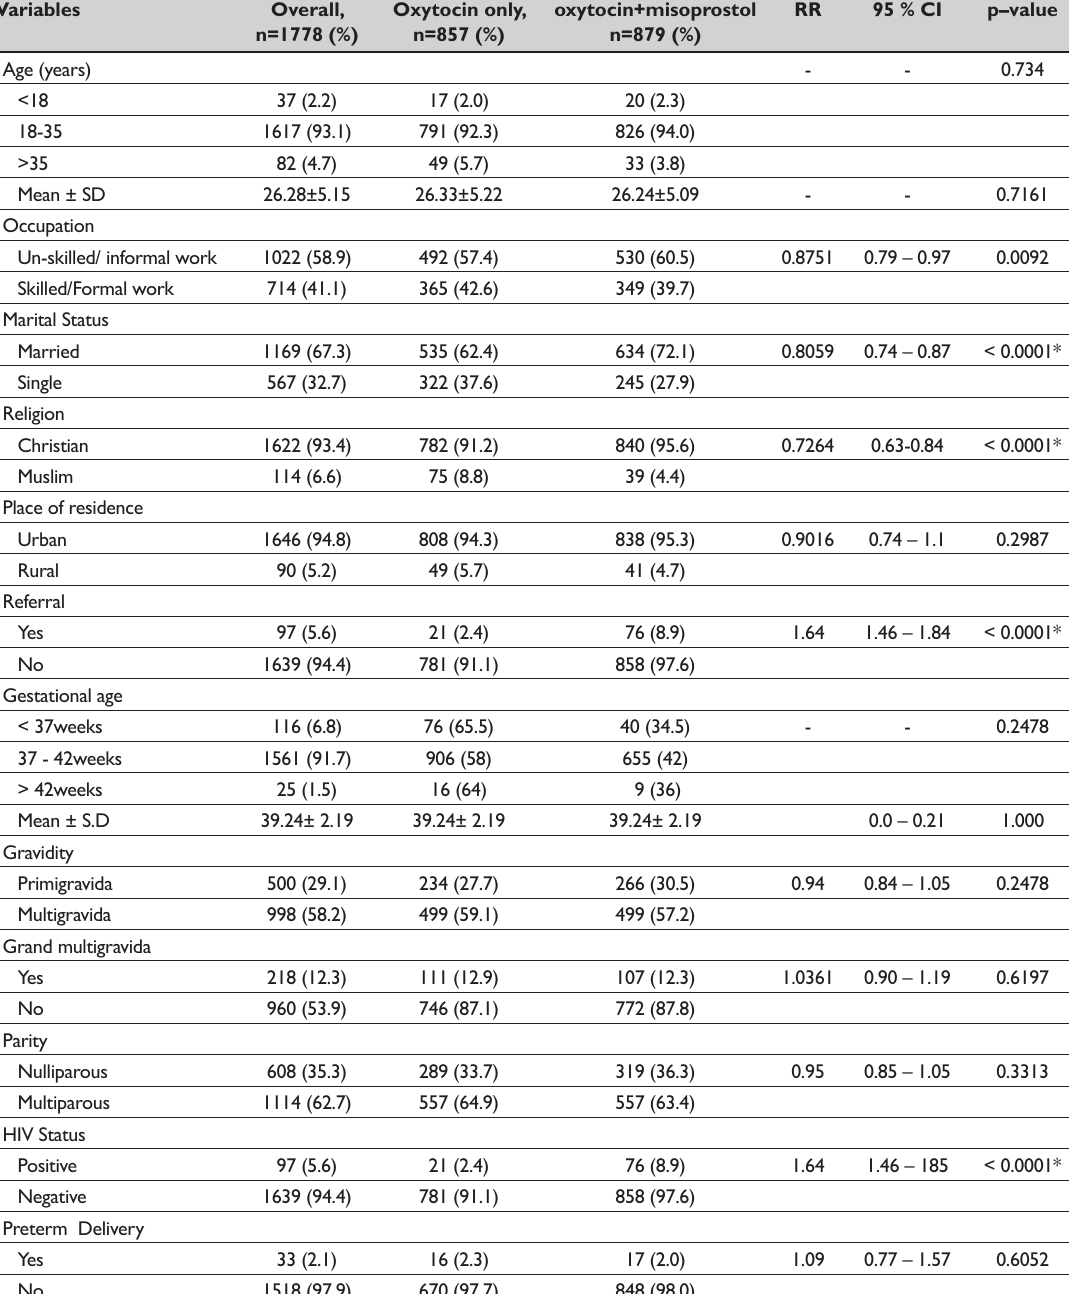
Table 1: Sociodemographic and clinical characteristics of parturients